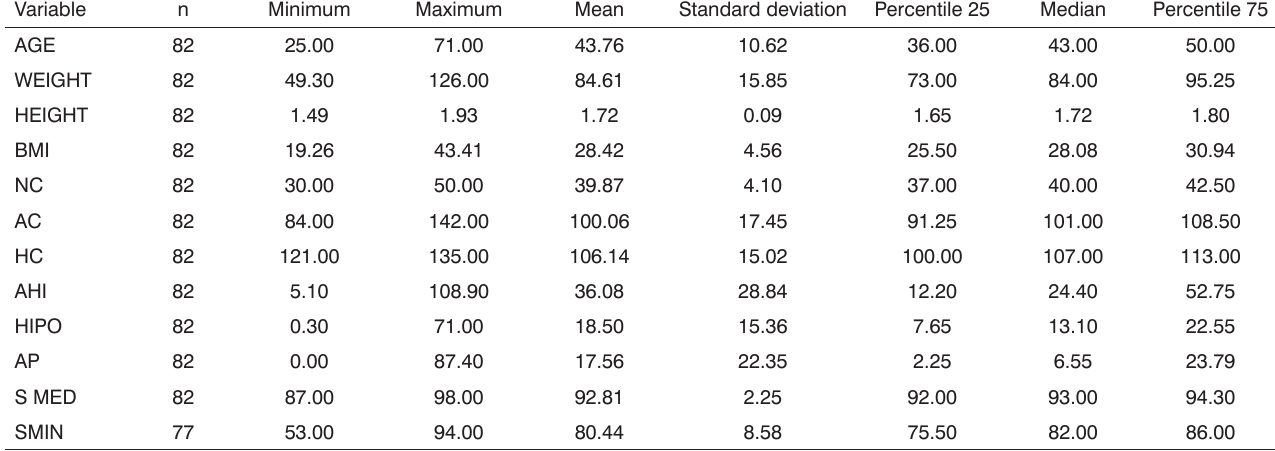
Table 1. Description of scalar variables.